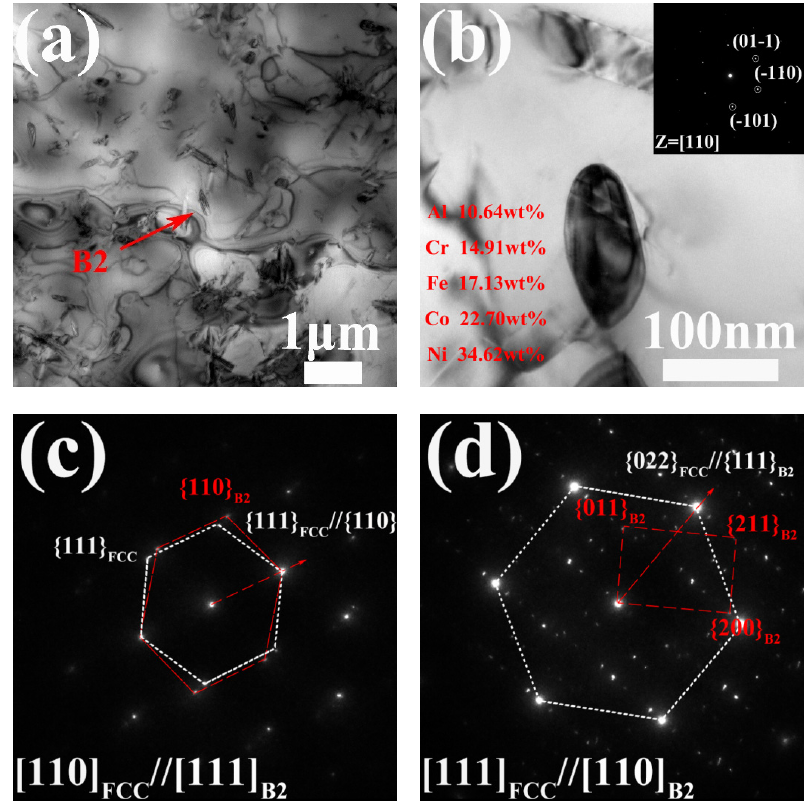
Figure 4. TEM images and corresponding SADP of B2 phase in AH800 sample: ( a , b ) BF images of B2 phase; ( c , d ) SADP of B2 phase and matrix phase; ( c , d ) SADP of B2 phase and